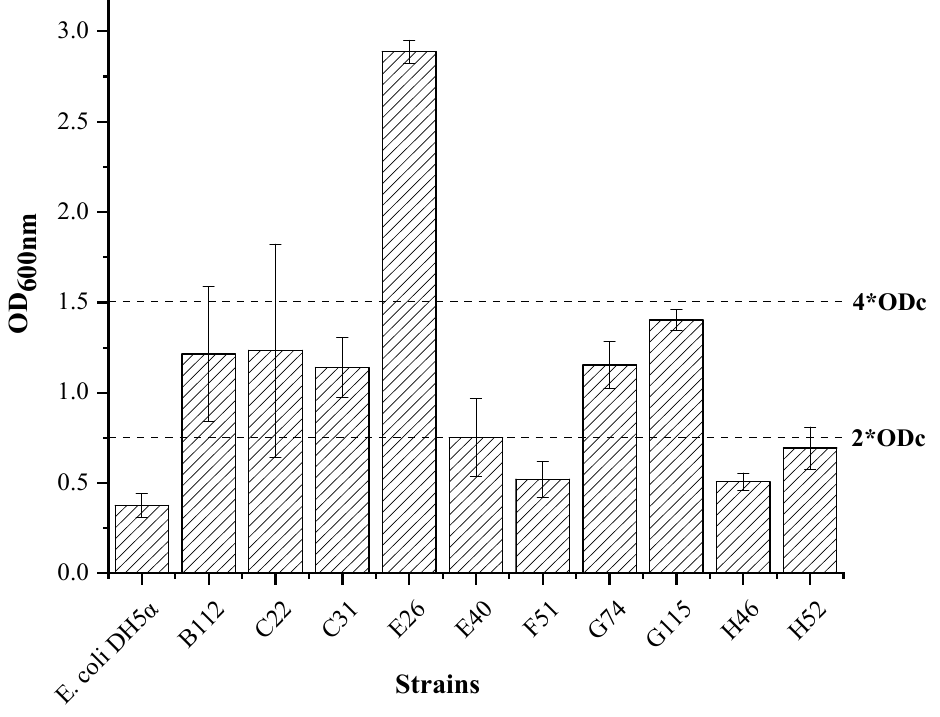
Figure 3. The film forming ability of QS bacteria. E. coli DH5 α was the negative control and its OD 600nm was presented as the ODc. The line-2*ODc was twice ODc. The line-4*ODc was four times ODc. Since biofilm formation is a dynamic process, the biofilm morphology of 10 QS bacteria was observed by CLSM after three days of cultivation [38]. In this study, we selected the biomass, average thickness, average diffusion distance, and surface area to volume ratio of the microbial envelope to characterize the biofilm structure produced by these 10 QS bacteria. Biomass was measured as the number of microorganisms per unit area, the average thickness indicated the spatial size of the biofilm, and the average diffusion distance and the surface area to volume ratio reflected the proportion of the microbial biofilm that contacted the nutrient source and the ability of microbial coatings to be adapted to the environment [39]. In addition, we used COMSTAT software to analyse the various parameters of the microbial coating, and the results are presented in Figure 4. After three days of cultivation, the microbial coating growth of the 10 QS bacteria is shown in Figure 4. According to the intuitive judgement of the picture results, it could be concluded that the biofilm biomass of the 10 QS strains increased significantly and showed structured microbial envelope morphology. Among them, the biomass of C31, G115, H52 and G74 belonging to the Ponticoccus genus was larger, 6.634–8.686 mg/cm 3 . Due to